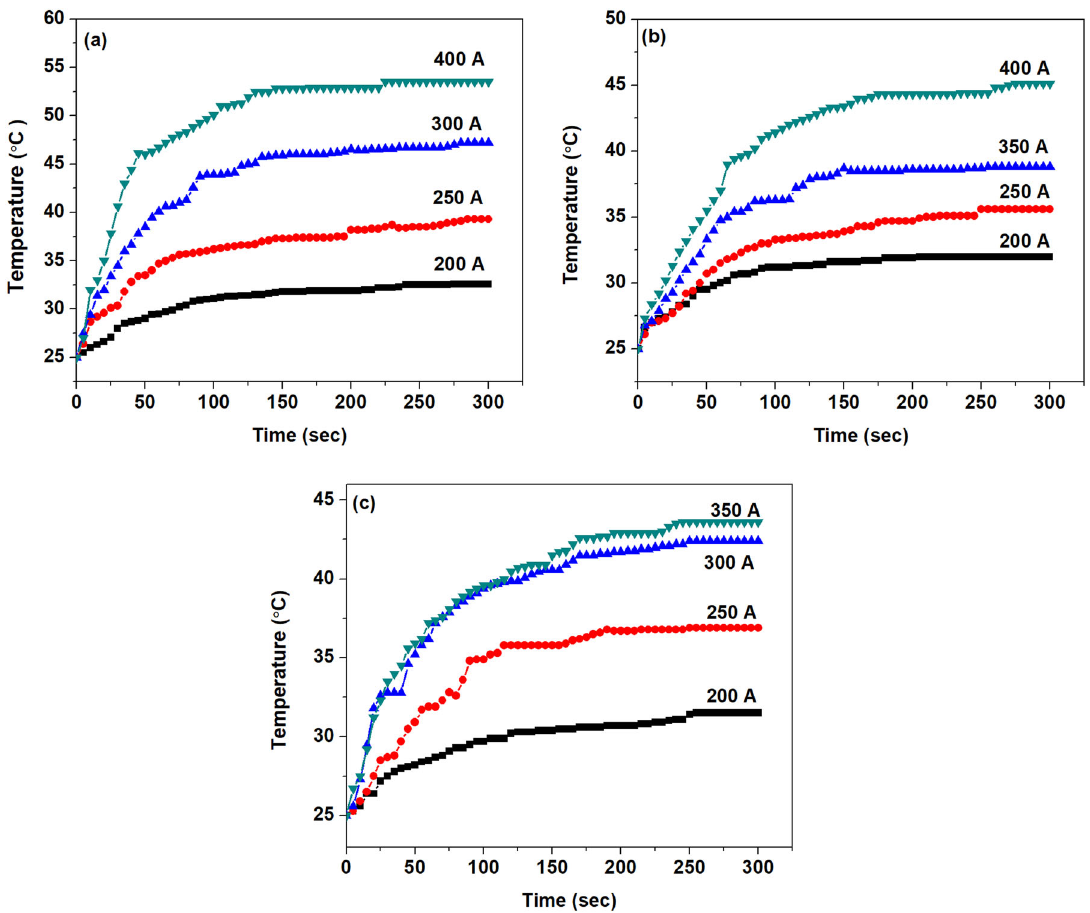
Fig. 10 Time-temperature graph of a Fe 3 O 4 , b PANI-coated Fe 3 O 4 , and c polypyrrole-coated Fe 3 O 4 with 1 mg concentration on exposure to 200 – 400 A (ac) current with a frequency of 280